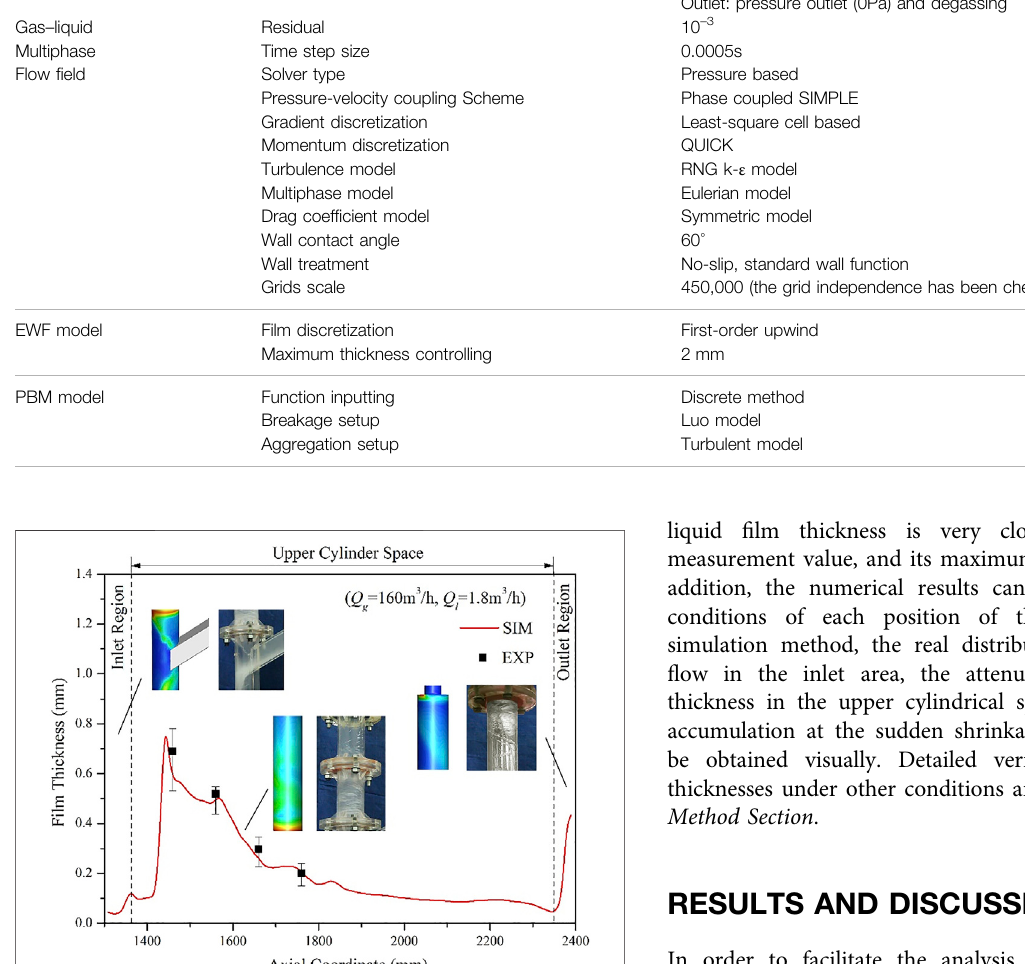
Frontiers in Chemical Engineering |